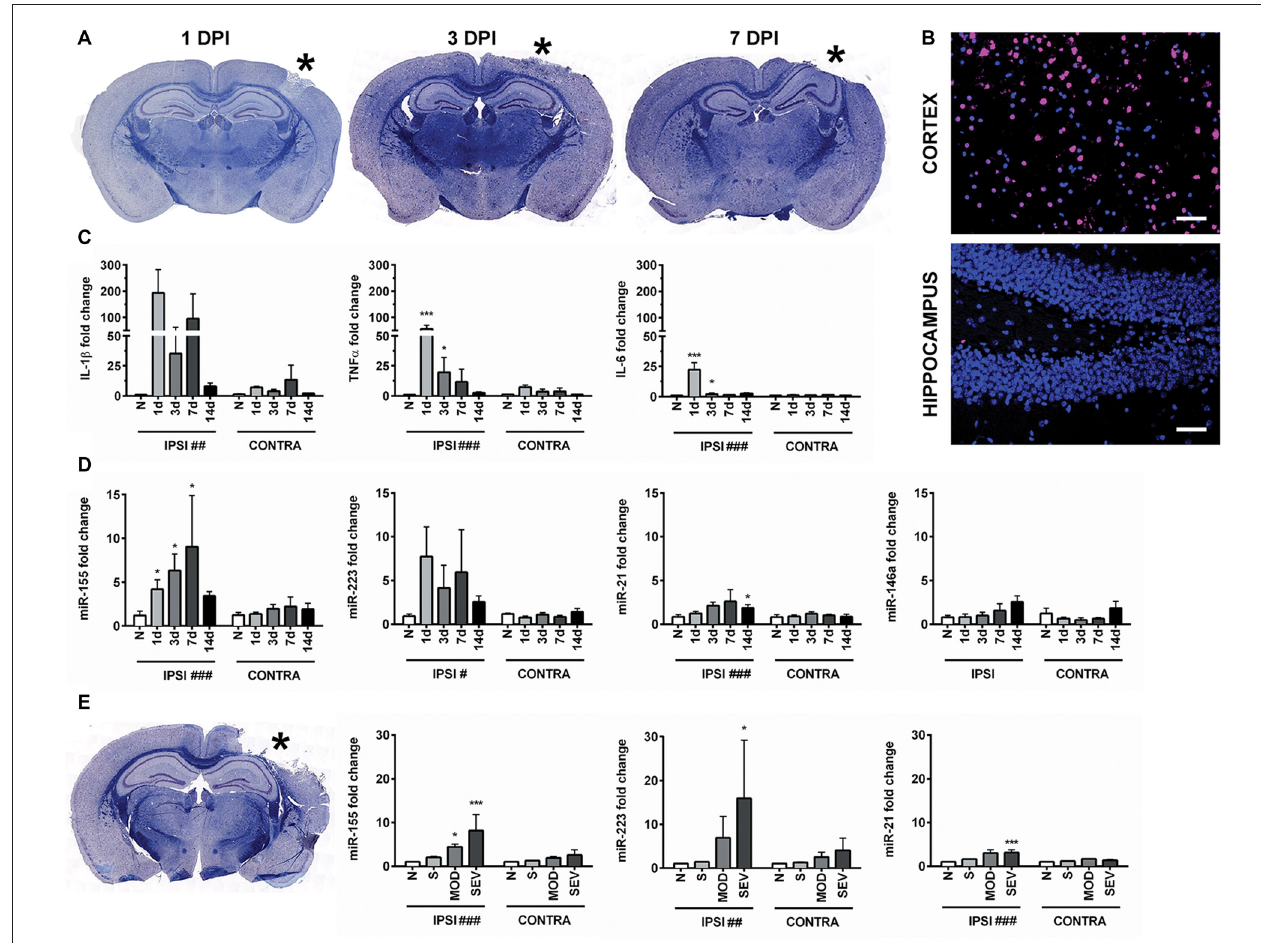
FIGURE 1 | Controlled cortical impact (CCI) increases inflammation-associated microRNAs (miRNAs) in the hippocampus. (A) Anatomical characterization of moderate CCI 1, 3, or 7 days post injury (DPI), myelin (Blue) and Nissl (Purple). (B) Staining for apoptotic cells using terminal deoxynucleotidyl transferase dUTP nick end labeling (TUNEL; magenta), nucleus (blue). Images show ipsilateral hemisphere 1 day after moderate CCI in the hippocampus and the lesion boundary of the cortex. Scale bars = 50 µ M. (C) Levels of inflammatory cytokines and (D) inflammation-associated miRNAs in the ipsilateral (IPSI) and contralateral (CONTRA) hippocampus 1, 3, 7 and 14 days after CCI by qPCR at 0.5-mm injury depth and in naïve animals ( n = 3). (E) Anatomical characterization of severe CCI 3 DPI (left) and levels of miRNA in the hippocampus (right) were measured 3 days after injury by qPCR in naïve ( n = 4), sham ( n = 4), moderate CCI ( n = 3), and severe CCI mice ( n = 4). Data are expressed as fold change relative to naïve mice. The mean ± SEM are shown. # P < 0.05; ## P < 0.01; ### P < 0.001 by two way ANOVA. ∗ P < 0.05; ∗∗∗ P < 0.001 by Bonferroni post hoc testing relative to the contralateral